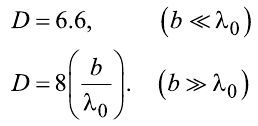
Moderate-size (approx. 10 μ m) Bi 2 Sr 2 CaCu 2 O 8+ δ mesa